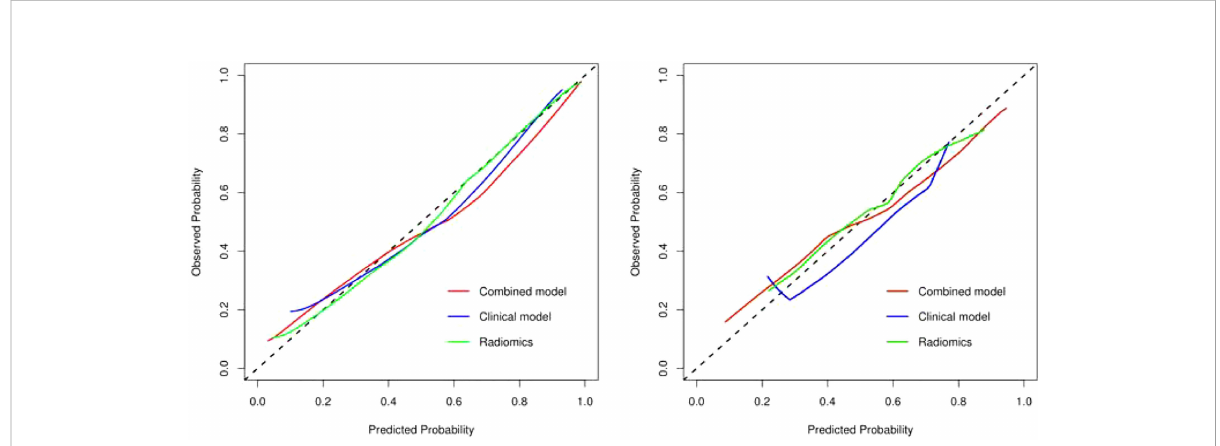
FIGURE 8 The calibration curve analysis of combined radiomics nomogram, clinical, and radiomics models (left, training set; right, validation set). The 45° line represents a perfect match between the actual (Y-axis) and the probability of differential diagnosis combined with combined radiomics nomogram, clinical, and radiomics prediction (X-axis). The closer the distance between the two curves, the higher the accuracy of prediction and actual observation of thymomas risk categorization. .